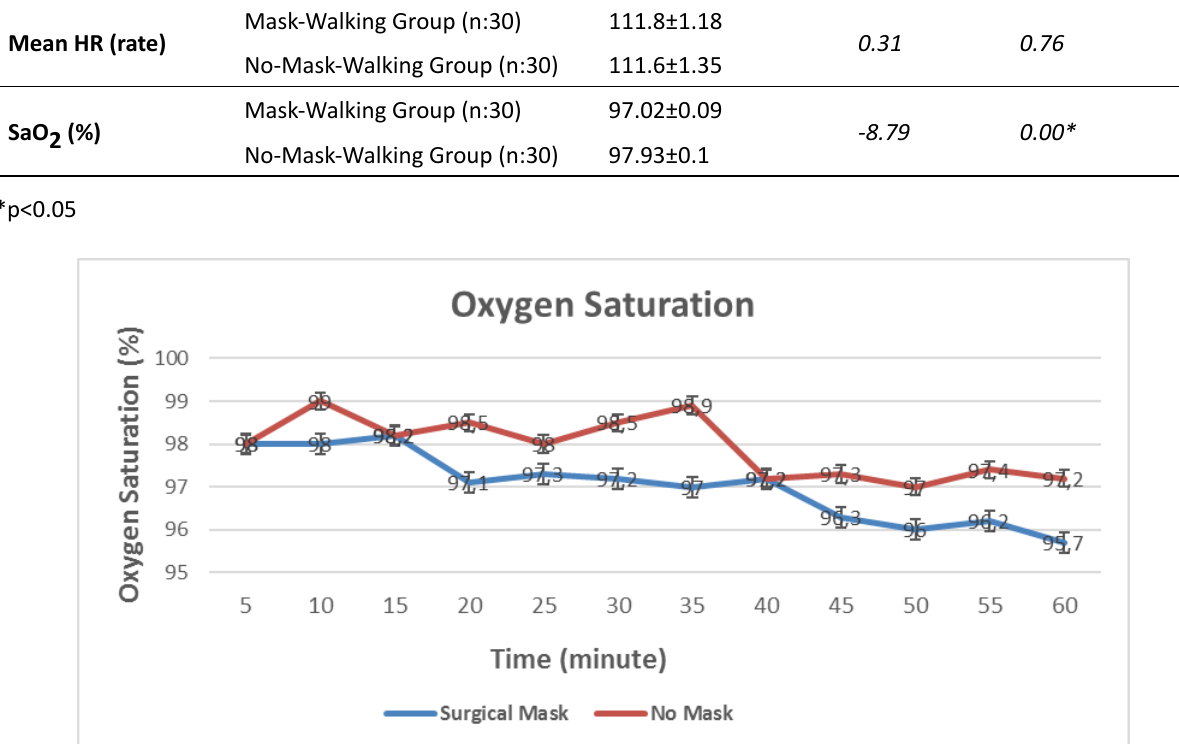
Table 2. Comparing the mean HR and SaO2 values of the mask-walking and no-mask-walking group Parameters